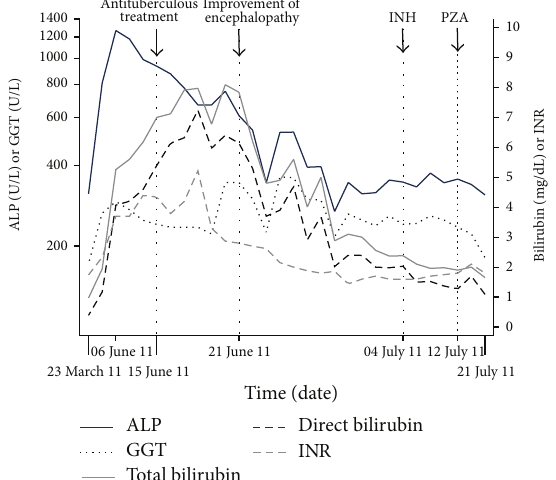
Figure 2: Liver function tests during the patient management. ALP denotes serum alkaline phosphatase; GGT, gamma glutamyl transferase; INH, isoniazid; PZA,